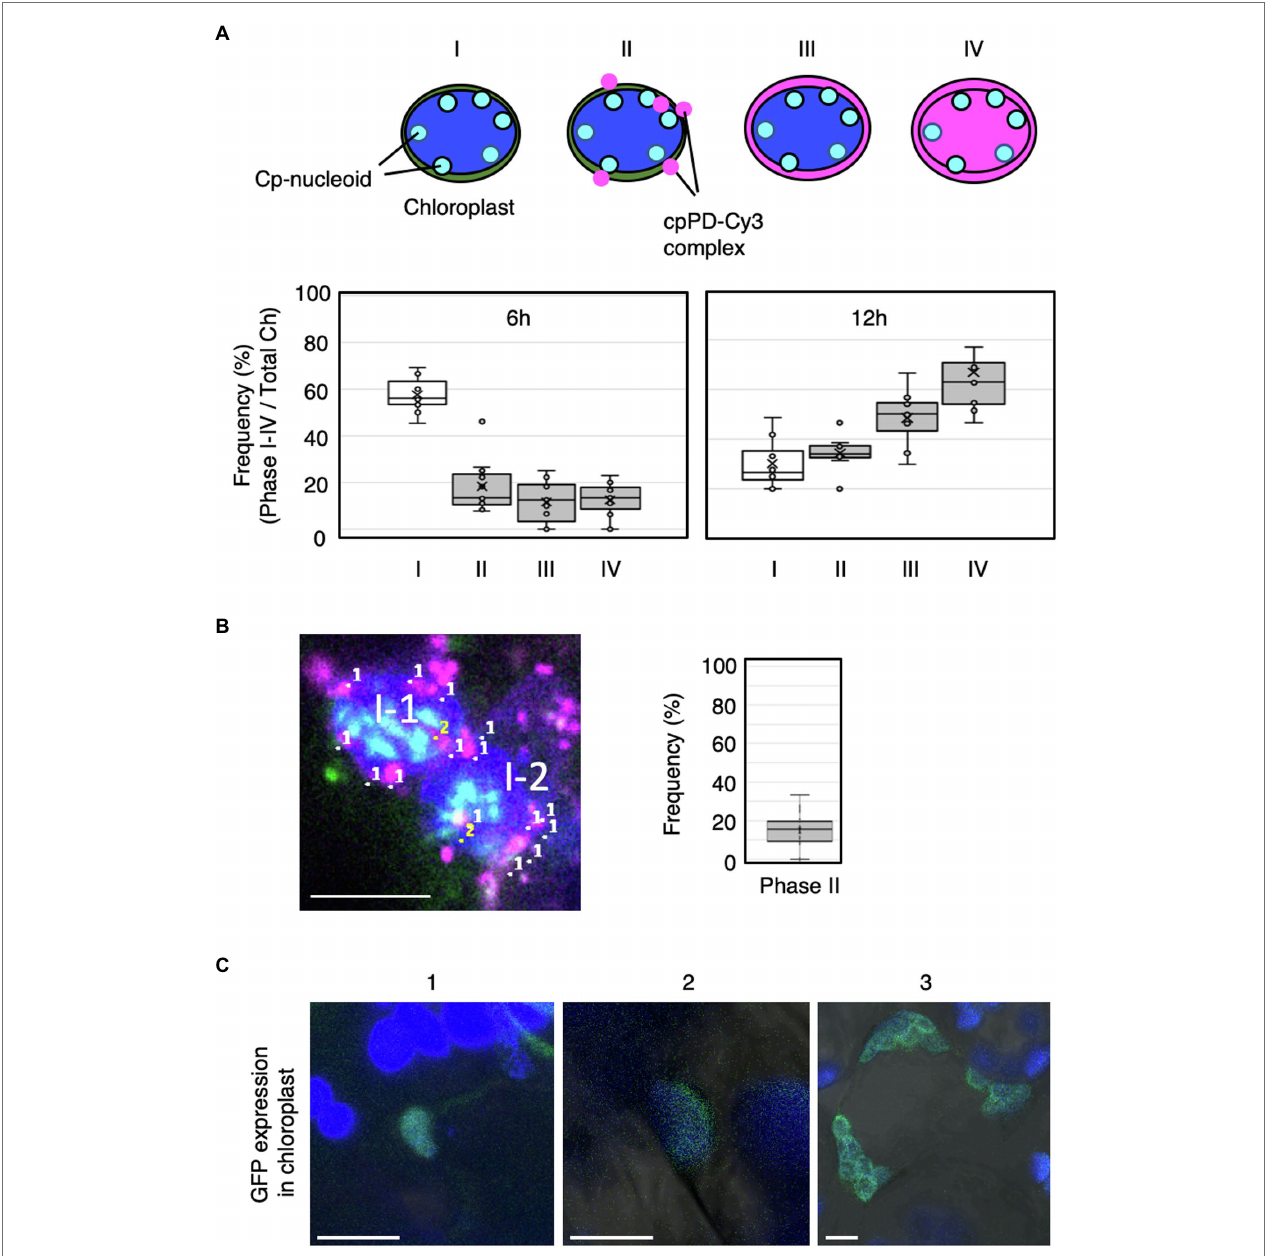
FIGURE 6 | Frequency of cpPD-Cy3 complex accumulation in and around the chloroplast. (A) Top, schematic representation of the four phases of cpPD-Cy3 complexes penetrating into chloroplasts. Bottom, distribution of the frequency of chloroplasts showing Phase I–IV (I–IV) stages at 6 and 12 h after infiltration. (B) Numbers in the image at the left panel represent cpPD-Cy3 complexes (magenta) (1) and the complex with nucleoids (sky blue) (2) in two mesophyll cells (II-1, II-2). The frequency of cpPD-Cy3 complexes bound to the cp-nucleoids is shown. (C) Three different images (1–3) of sfGFP (green) accumulation in transformed chloroplasts by the cpPD complex. Chloroplasts (blue) are visualized as chlorophyll autofluorescence. Bars = 5 μ